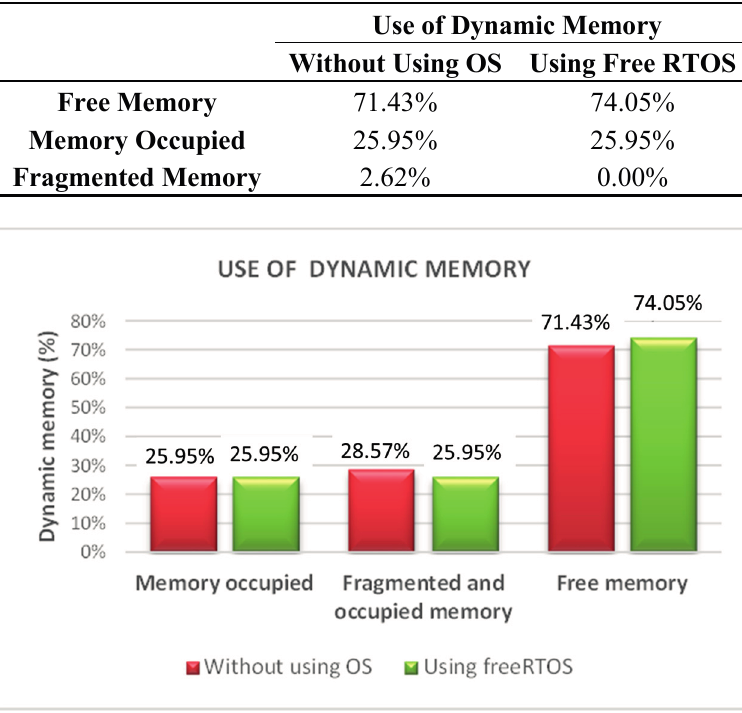
Figure 22. Dynamic memory using an OS.